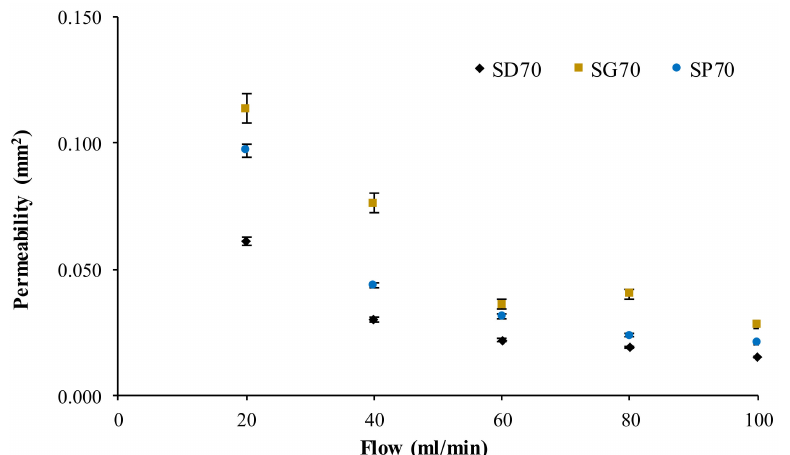
Figure 4. Calculated permeability for the TPMS sca ff olds as a function of the flow rate, including the experimental standard